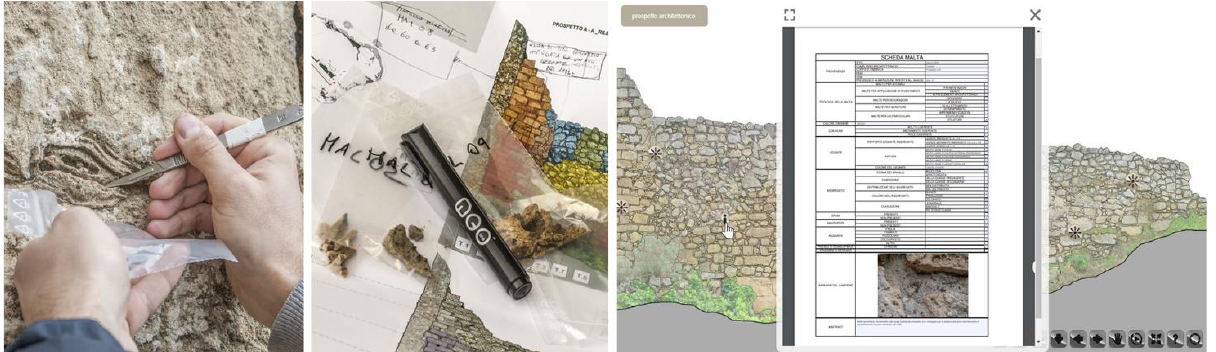
Figure 4. The mortars analysis: collection, cataloguing and identification in wall hangings